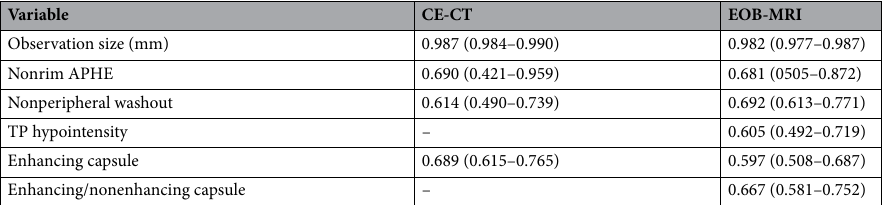
Table 2. Interobserver Agreement for LI-RADS Imaging Features of HCCs in Contrast-Enhanced CT and Gadoxetic Acid-Enhanced MRI. Data are expressed as intraclass correlation coefficient (ICC) for observation size and as κ value for nonrim APHE, nonperipheral “washout”, TP hypointensity, enhancing “capsule”, and nonenhancing/enhancing “capsule”. Data in parentheses are expressed as 95% confident intervals. CE-CT contrast-enhanced CT, EOB-MRI gadoxetic acid-enhanced MRI, APHE arterial phase hyperenhancement, TP transitional phase.